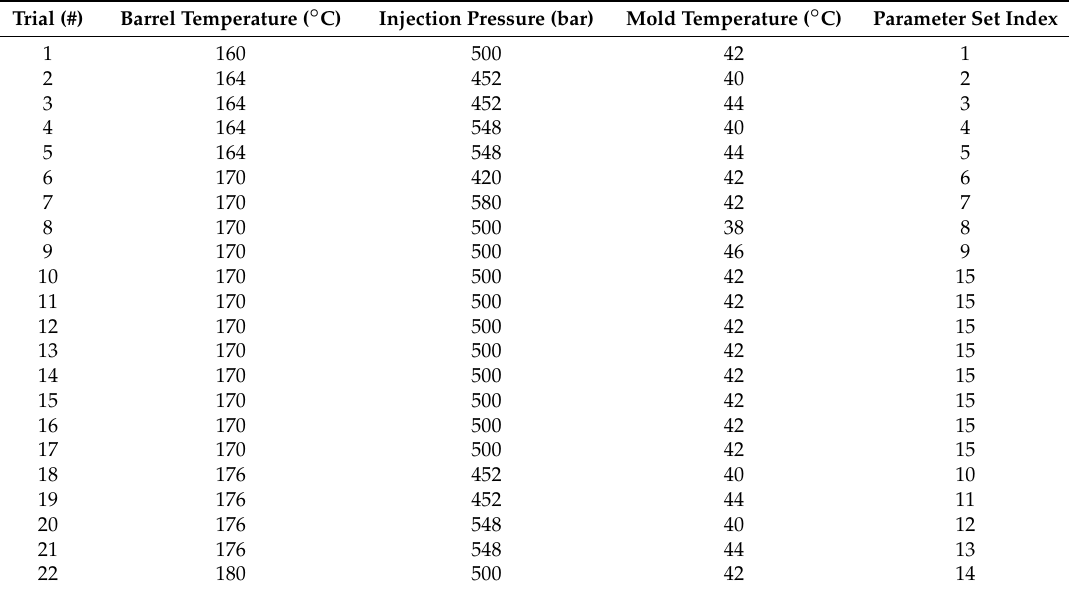
Table 2. Parameter set for each